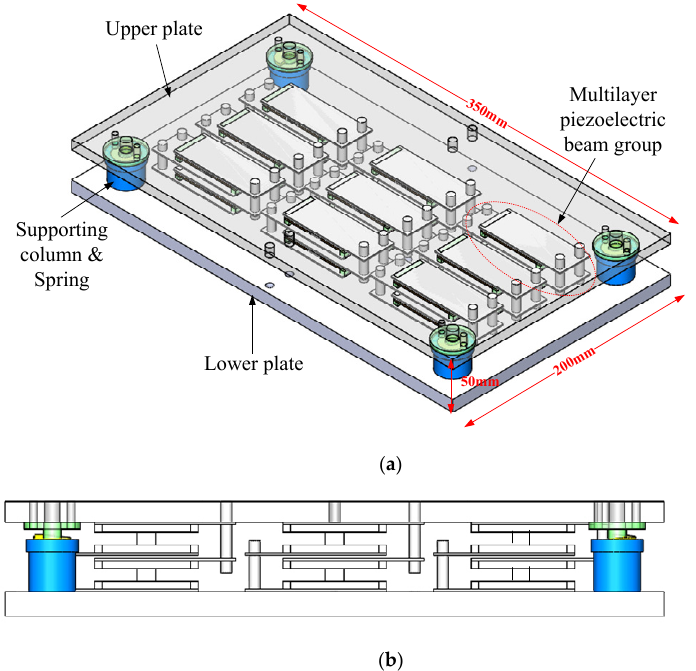
Figure 3. Structure of the energy harvesting floor: ( a ) three-dimensional view; ( b ) front view.